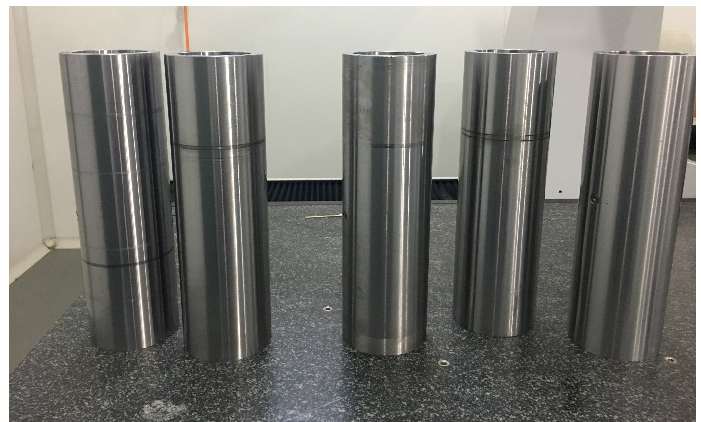
Figure 6. Drawing of 5 finished motorized